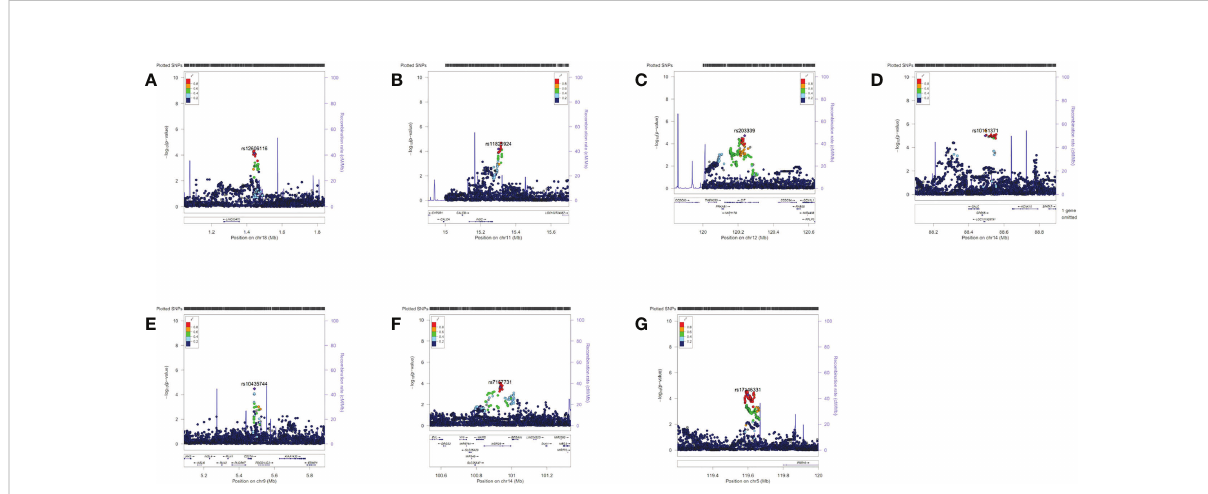
FIGURE 1 Region plots of the genome-wide association results of the suggestive single-nucleotide polymorphisms (SNPs). These region plots were made in LocusZoom (http://locuszoom.sph.umich.edu) with hg19/1000 Genomes Nov 2014 ASN as the LD Population. The selected SNP was in purple and its linkage disequilibrium values (r2) with nearby SNPs are indicated by different colours. (A) rs12606116 ± 400 kb (18p11.32) (B) rs11826924 ± 400 kb (11p15.2) (C) rs203339 ± 400 kb (rs433091, 12q24.23) (D) rs10151371 ± 400 kb (rs17124022, 14q31.3) (E) rs10435744